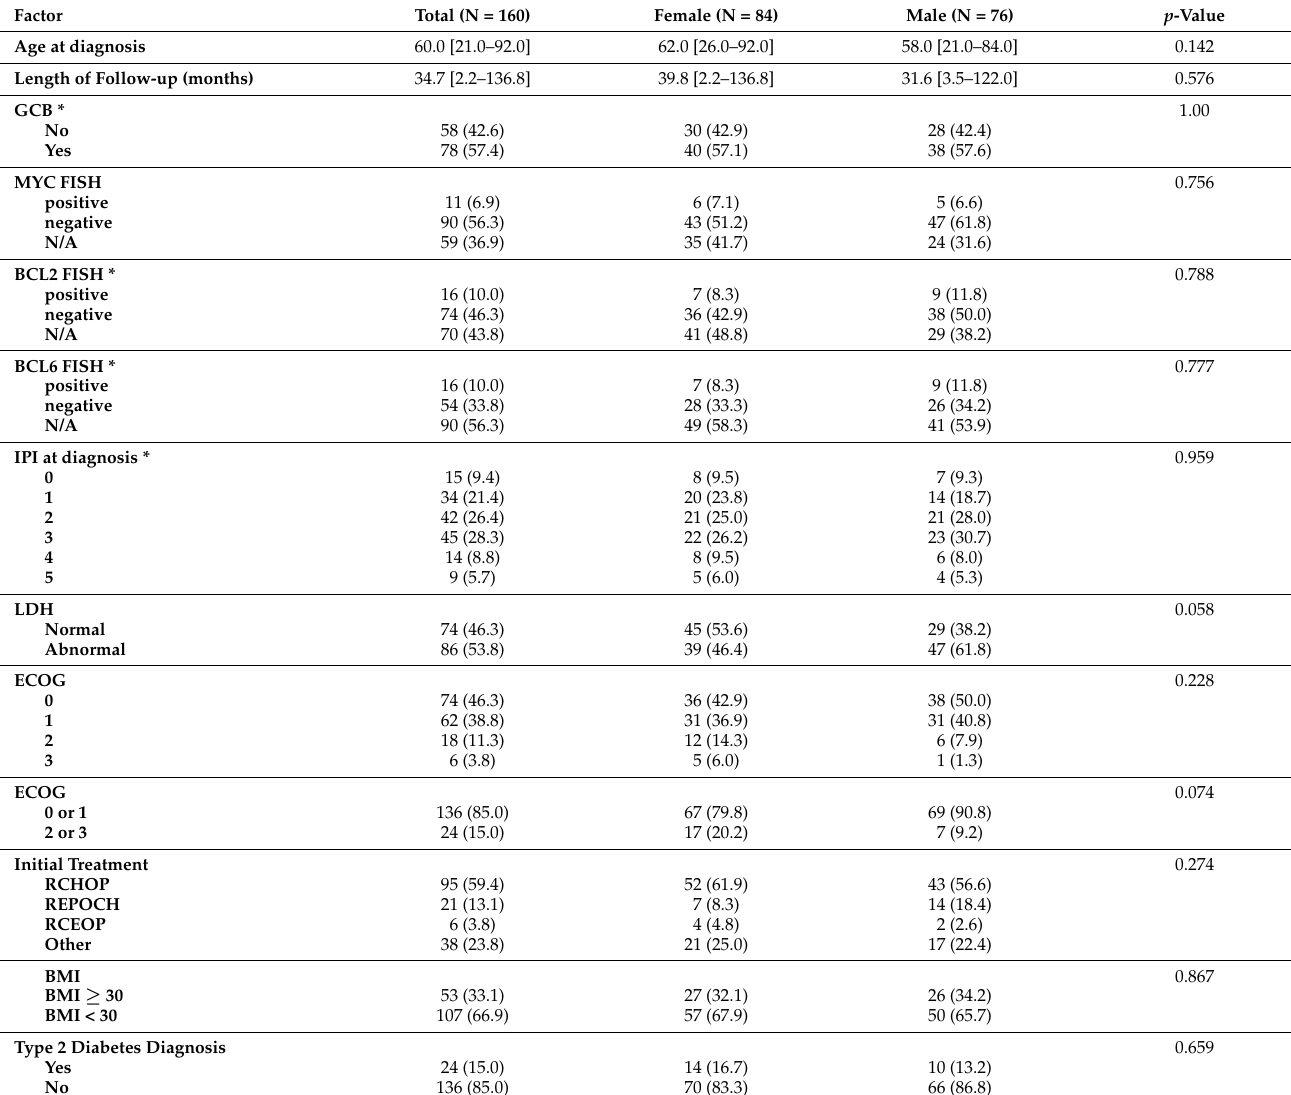
Table 1. Clinical and pathologic characteristics for patients in this study.